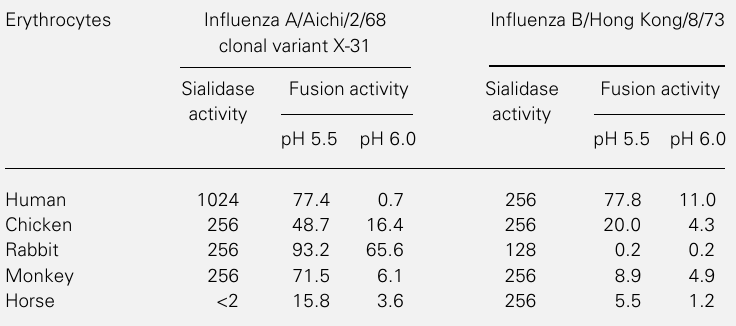
Table 1 - Comparison of sialidase and fusion activities of influenza A and B viruses on erythrocytes from different sources. Sialidase activity was measured in a neuraminidase-lectin assay and is reported as the reciprocal of the highest virus dilution causing complete hemagglutination by PNA. Fusogenic activity was measured by hemolysis and activity is reported as percent hemolysis measured at 545 nm. All virus strains were previously standardized at 1,024 HAU/25 µl.